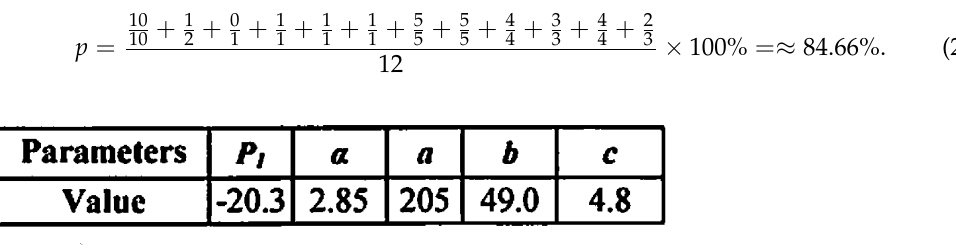
Figure 13. Printed table of scanned table image 1.